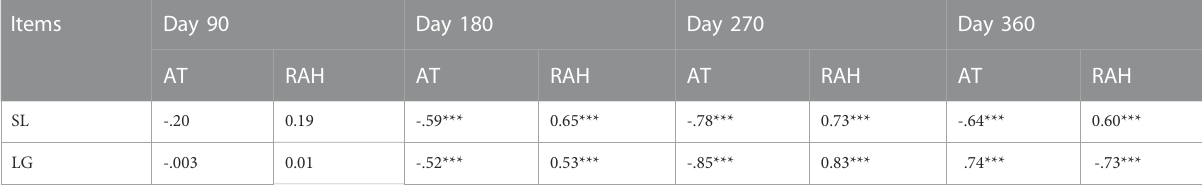
TABLE 1 Relationship between CO 2 emission rate and environmental factors on the daily scale ( n = 72).